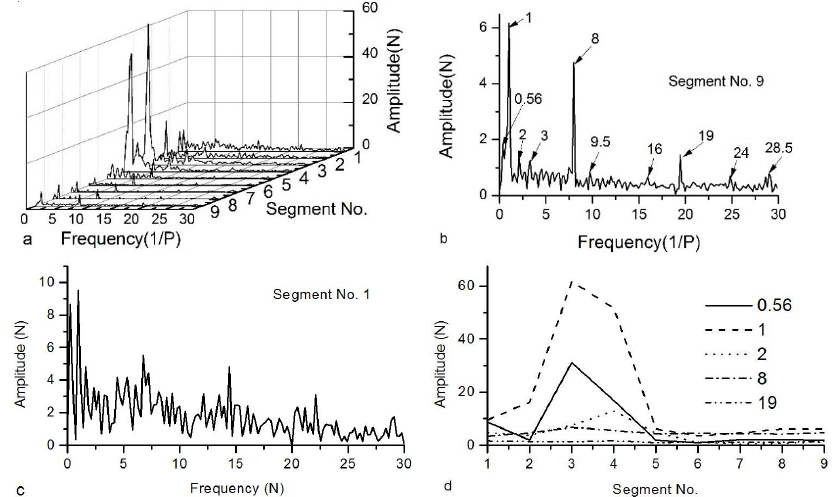
Figure 10. Variations in the friction frequency spectrum with the WP at a backward feed of 5 mm/min. ( a ) Friction frequency spectrum of all the segments; ( b ) Friction frequency spectrum of segment No.9; ( c ) Friction frequency spectrum of segment No.1; ( d ) Amplitude of all segments for significant frequency components.